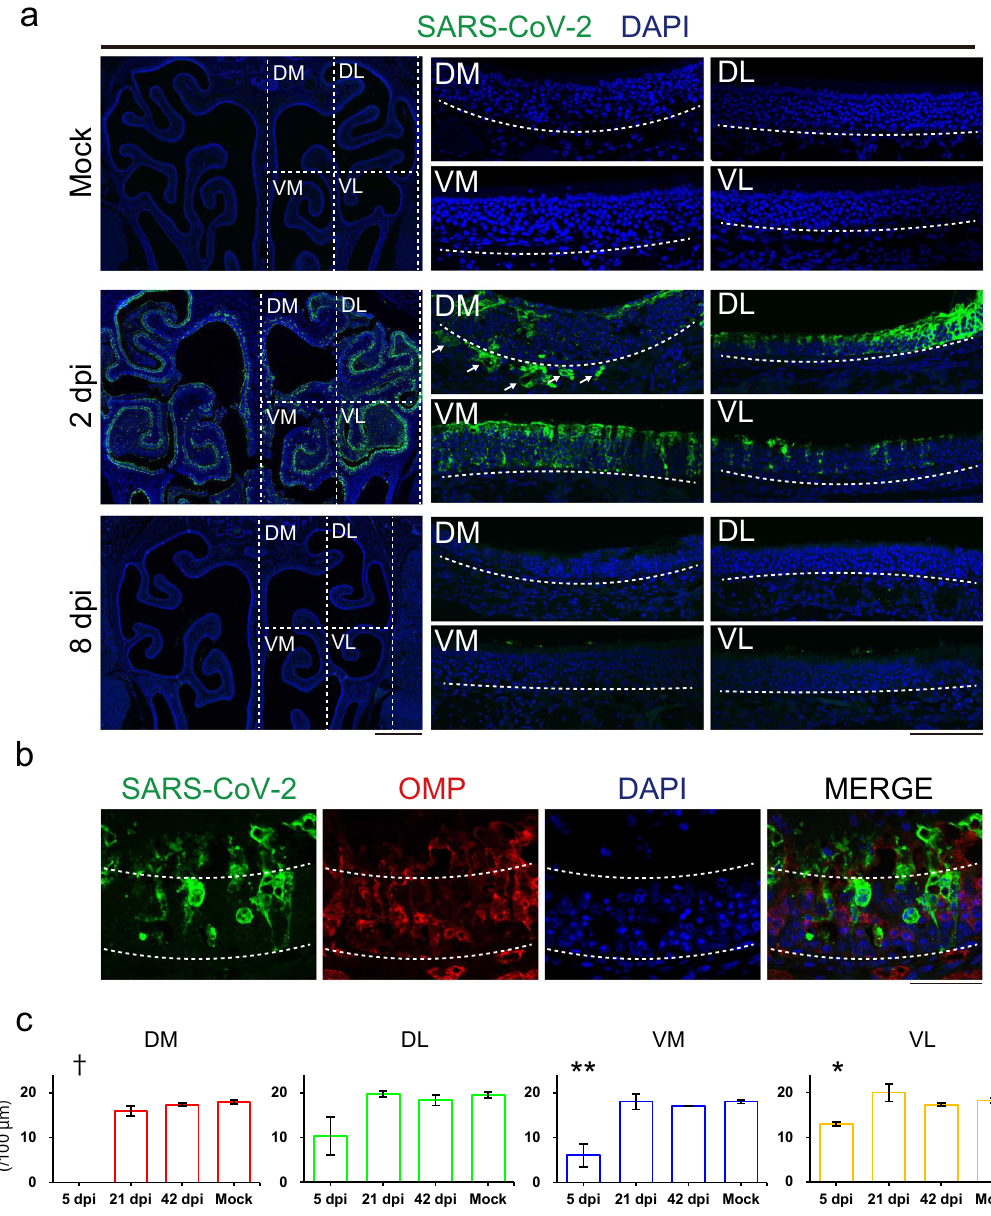
Figure 1. Distribution of severe acute respiratory syndrome coronavirus 2 (SARS-CoV-2) in the OE. (a) Distribution of SARS-CoV-2 in the olfactory epithelium (OE) at mock, 2 dpi, and 8 dpi. The OE was divided into 4 regions: dorsomedial (DM), dorsolateral (DL), ventromedial (VM), and ventrolateral (VL). SARS-CoV- 2-positive cells were localized in the 4 regions of the OE at 2 dpi. The white arrows indicate the SARS-CoV-2- positive cells in the lamina propria. Scale bars, 1 mm (left), 100 μm (right). (b) Profile of SARS-CoV-2 infection in the OE. The apical white dashed line indicates the surface of the epithelium. The basal white dashed line is the border of the OE and lamina propria. Scale bar, 50 μm. (c) Numbers of the supporting cells (SCs) in the OE in DM, DL, VM, and VL (one-way ANOVA followed by Dunnett’s post hoc test. *p < 0.05, **p < 0.01, ***p < 0.001, † means unevaluable as the OE was completely desquamated and SCs were not detectable). Number of samples; n = 3 (5, 21 and 42 dpi) and 4